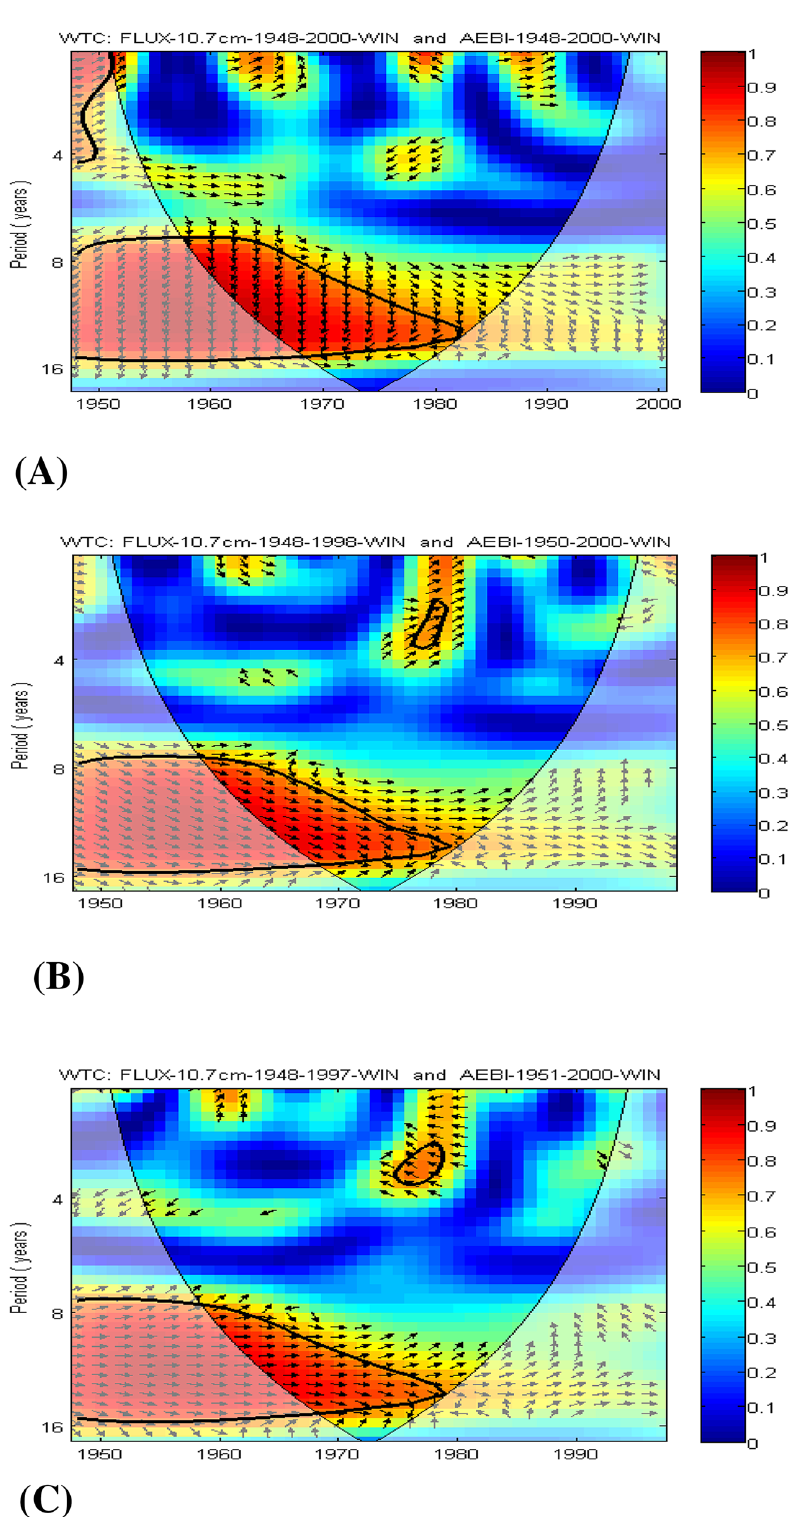
Figure 4. Wavelet coherence (WTC) between solar flux and AEBI during winter, for Period I: ( A ) unfiltered time series; ( B ) 2 years lag; ( C ) 3 years